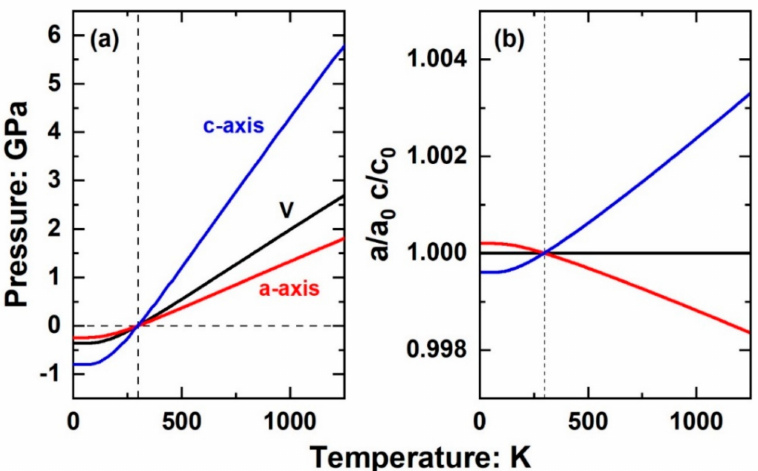
Figure 4. ( a ) The lines of constant a and c cell parameters of zircon passing through room T and P do not coincide with the isochor. ( b ) As a consequence, there are significant changes in the a and c cell parameters along this